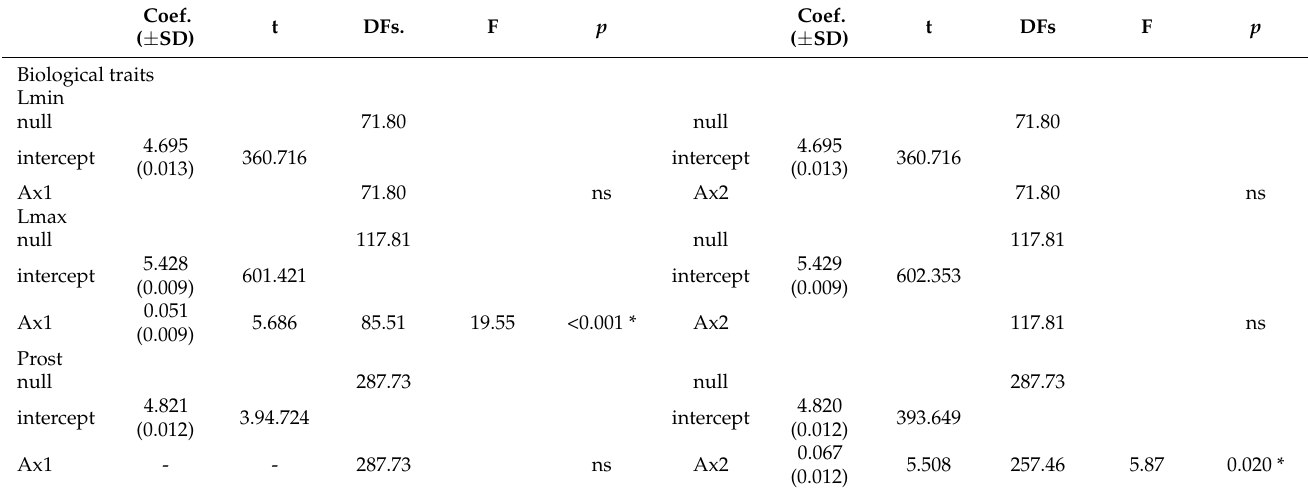
Table 8. Parameters and fitting values of the generalized linear models (GLMs) for mean functional traits of Lumbricidae. Results constrained by hydrologic conditions (HC); time (T) and local to- pography (LT) used as covariates. Regression coefficient (Coef. = slope), SD — standard deviation, 71.80 71.80 t — value statistic to test if the coefficient is different from zero, DFs — residual deviance, F — value statistic to test the fit of the model after introducing each variable (df for null model = 53, for Ax1 117.81 and Ax2 = 52 for all the traits). Trait codes as in Table 2.